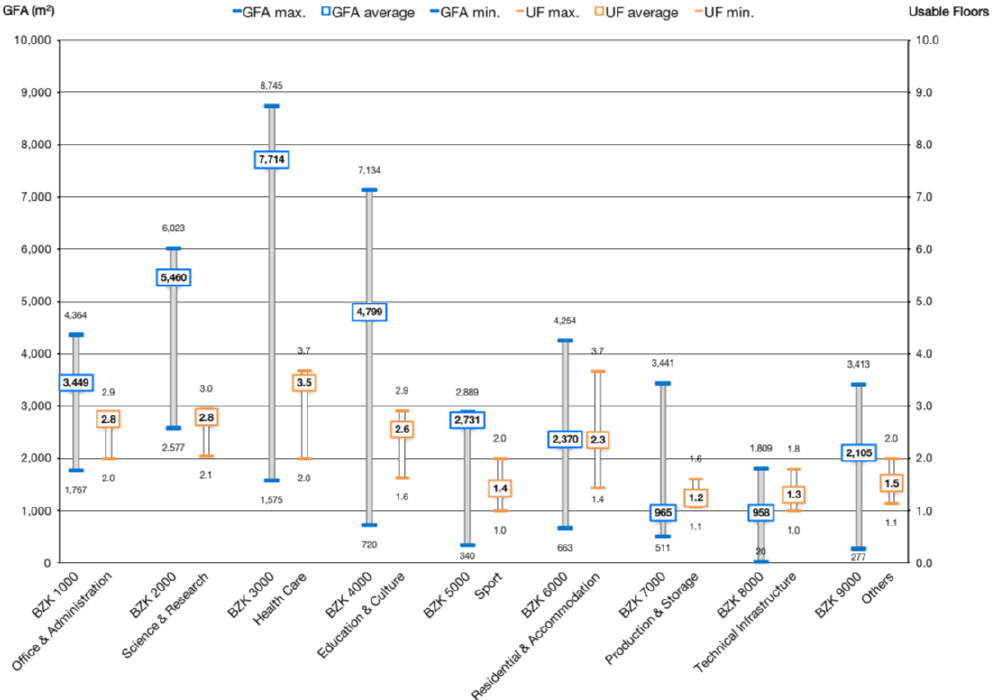
Figure 3. Empirical survey of the average values of the main categories (first digit) and spread in the subcategories (second digit), separated by gross floor area (GFA) and above-ground usable floors (UF) (own representation according to [10]).